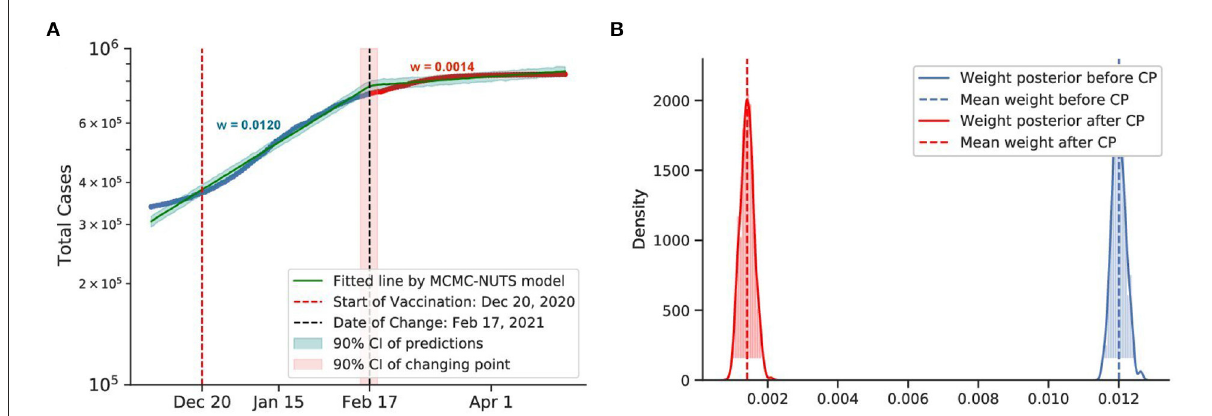
FIGURE12 Posterior for Israel. Israel recorded more than 30,000 cases when they started the vaccination program on December 20, 2020 (78). After the vaccination took its affect, the growth rate declined by 88%, from 0.0120 to 0.0014. The change-point point was around February 17, 2021. (A) Fitted graph with change-point on February 17, 2021. (B) Posterior distribution of weights (transmission rate) before and after